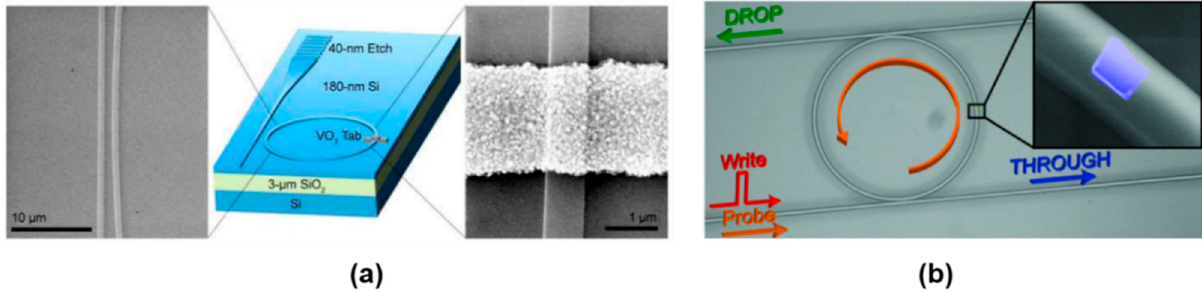
Figure 11. Integrated PCM-based photonic switches. ( a ) Reproduced from [49] with permission from OSA. ( b ) Reproduced from [50] with permission from Wiley.